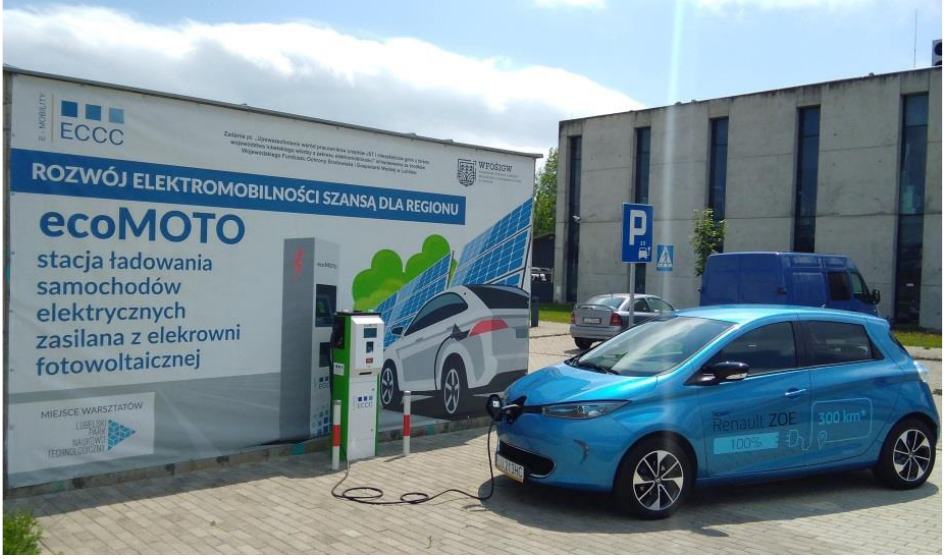
Figure 10. Electric vehicle charger installed for Sector 5 in the LSTP.